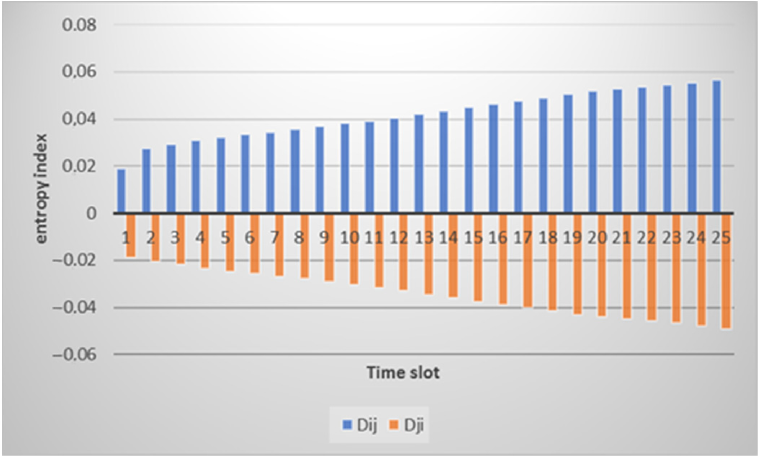
Figure 15. The result of calculating the entropy for received packets by node i relative to node j (marked in yellow) and by node j relative to node i (marked in orange) under conditions of a deauthentication attack.